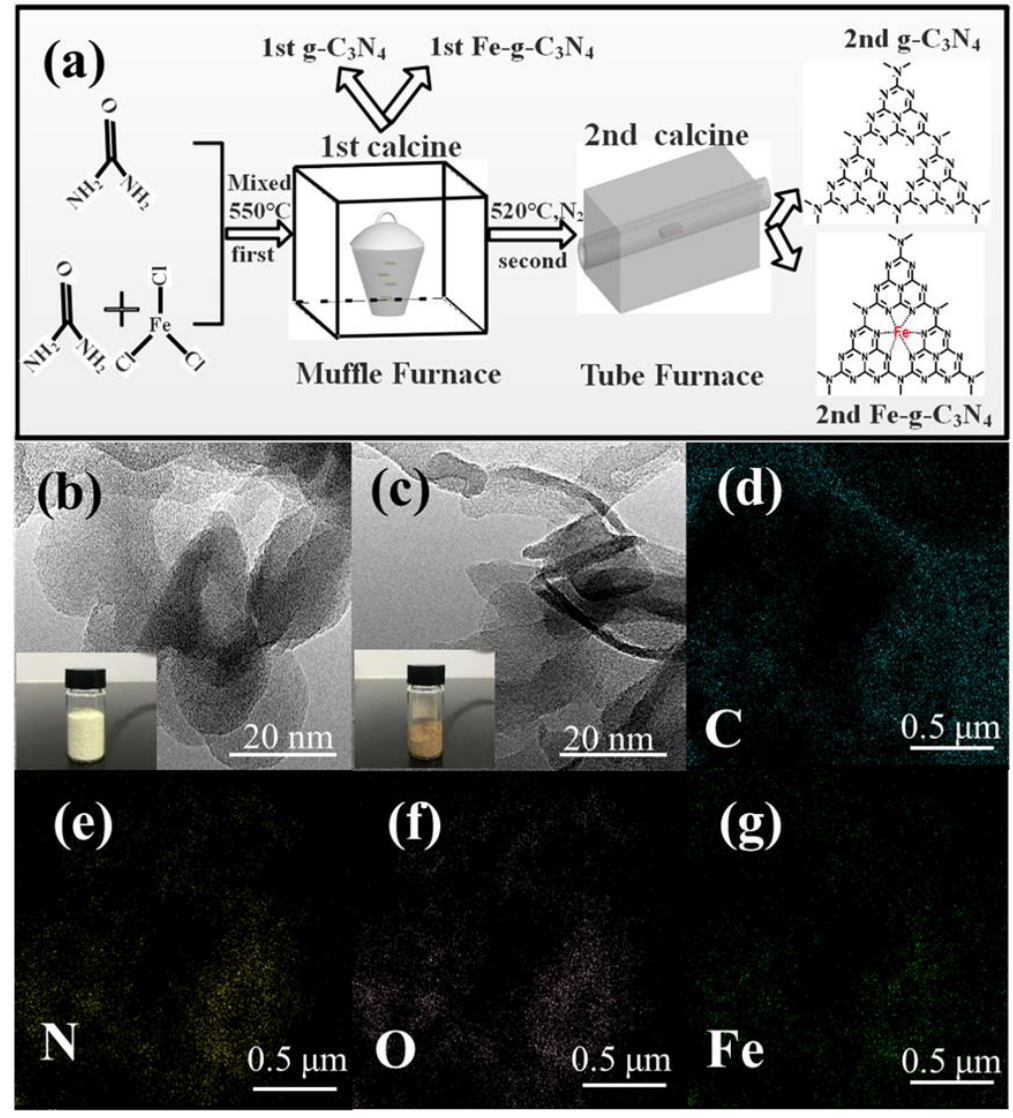
Figure 1. ( a ) Schematic of the one-step and two-step calcination process for the synthesis of g–C 3 N 4 and Fe–g–C 3 N 4 , ( b ) TEM images of 2 nd g–C 3 N 4 , and ( c ) 2 nd Fe–g–C 3 N 4 ; ( d – g ) element mapping of 2 nd Fe-g-C 3 N 4 .